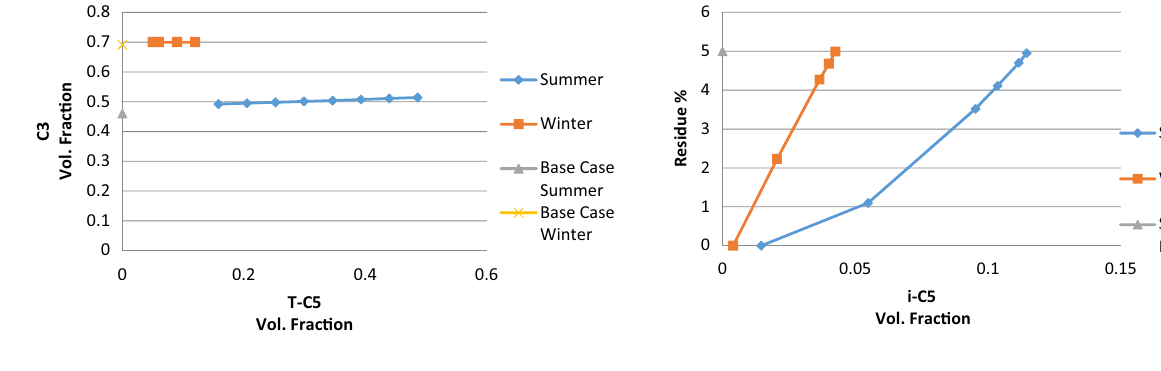
Fig. 28 Effect of adding a mixture of 2,2DMP and i-C5 on LPG pro-